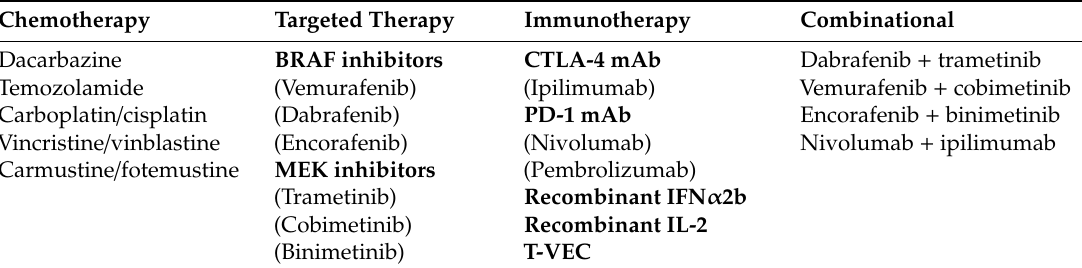
Table 1. Current systemic therapies available for